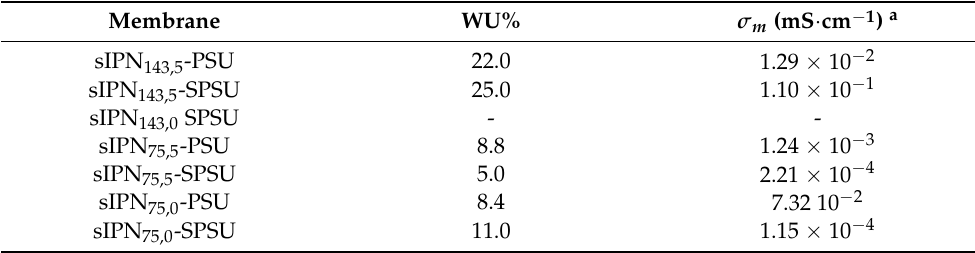
Table 2. Values of water uptake (WU%) and ionic conductivity ( σ m ) of the membranes at room